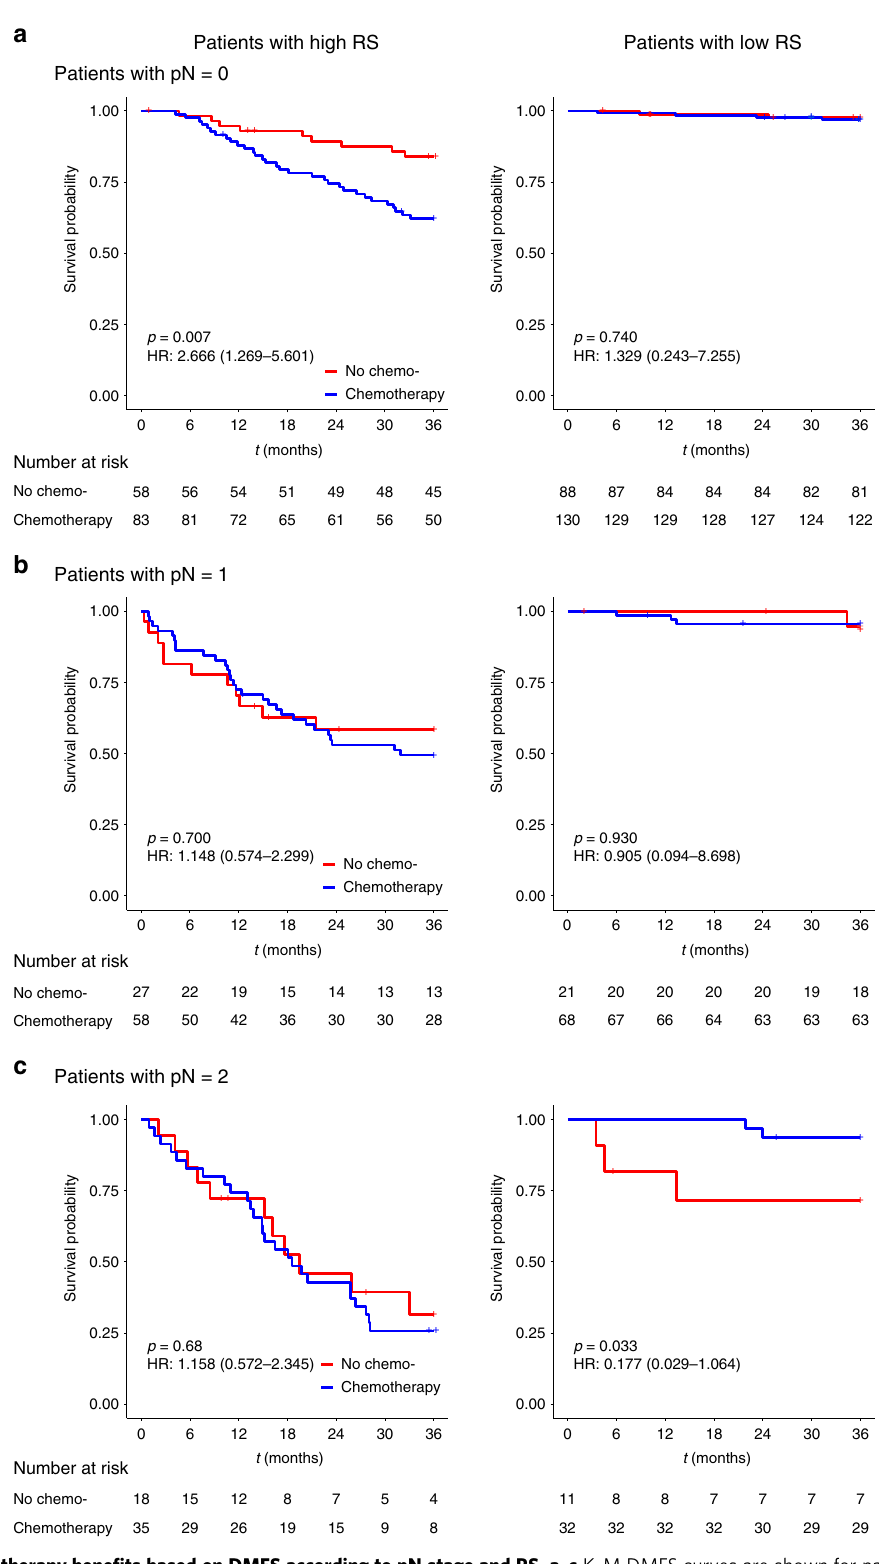
Fig. 6 Adjuvant chemotherapy bene fi ts based on DMFS according to pN stage and RS. a – c K – M DMFS curves are shown for patients according to their use of adjuvant chemotherapy. In addition, patients with a high RS (left) were strati fi ed according to pN0 ( n = 141, upper), pN1 ( n = 85, middle), and pN2 ( n = 53, bottom). Patients with a low RS (right) were also strati fi ed according to pN0 ( n = 218, upper), pN1 ( n = 89, middle), and pN2 ( n = 43, bottom). p values were calculated using two-sided log-rank test. RS radiomic signature; HR hazard ratio; DMFS distant metastasis-free survival; LARC locally advanced rectal cancer. Source data are provided as a Source Data fi